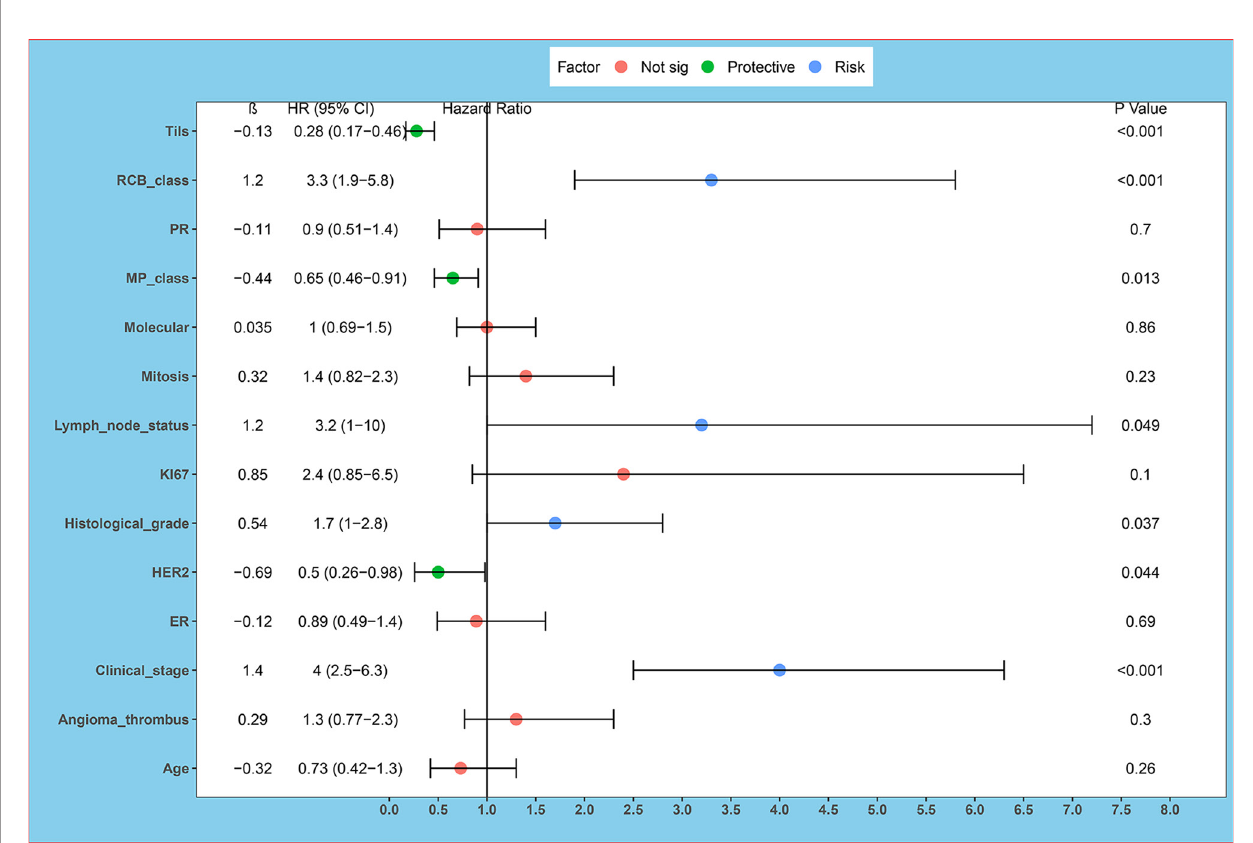
FIGURE 1 | Univariate survival analysis forest plot. ER, estrogen receptor; PR, progesterone receptor; HER2, human epidermal growth factor 2; Tils, tumor-in fi ltrating lymphocytes. Univariate survival analysis showed histological grade (P = 0.037), clinical stage (P < 0.001), HER2 (P = 0.044), RCB class (P < 0.001), Tils (P < 0.001), lymph node metastasis (P = 0.049), MP grade (P = 0.013) are related to OS in non-PCR patients after